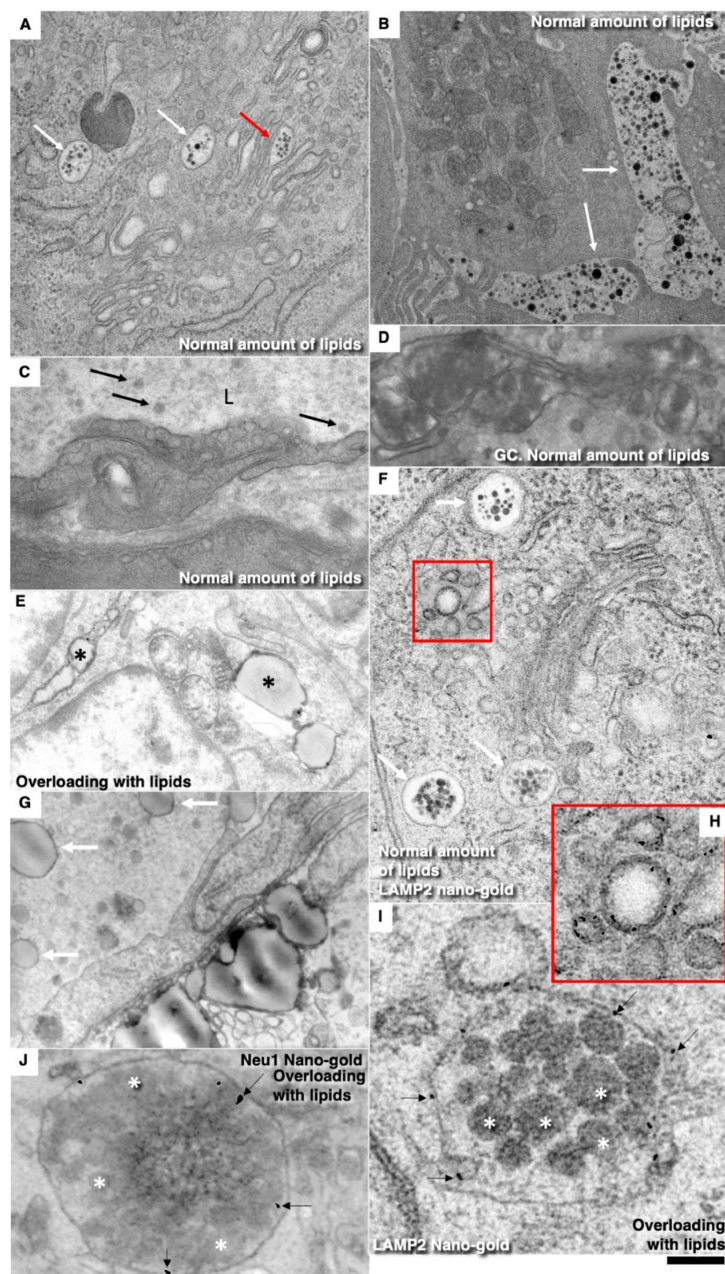
Figure 10. Overloading of enterocytes with lipids alters production of chylomicrons. ( A , B ) Control animals fed with a small amount of lipids. White arrows in ( A ) show post-Golgi carriers. Red arrows indicate the distension of the Golgi cisternae filled with normal chylomicrons. ( B ) Normal chylomicrons (white arrows) in the space between enterocytes. ( C ) Normal chylomicrons (arrows) in the lumen (L) of lymphatic capillary of the intestinal villi. ( D ) Large chylomicrons (significantly ( p < 0.05) larger than in control rats; quantified in Figure 11I) in the distensions of the Golgi cisternae. ( E ) Large chylomicrons (black asterisks) between enterocytes in the overloaded rats. ( F ) In normally fed rats, post-Golgi carriers (white arrows) contain normal chylomicrons but did not exhibit labeling for LAMP2. ( G ) Large chylomicrons (white arrows) are visible in the lumen of the lymphatic capillary of intestinal villus. ( H ) Enlarged area indicated in the red box in ( F ). White asterisks indicate enlarged chylomicrons. ( I , J ) Enlarged chylomicrons (white asterisks) are present in the compartment positive for LAMP2 ( I ) and Neu1 ( J ). (Scale bars: 250 nm ( A , F ); 330 nm ( B ); 500 nm ( C ); 820 nm ( D ); 2500 nm ( E ); 315 nm ( G ); 105 nm ( H ); 140 nm ( I ); 300 nm ( J